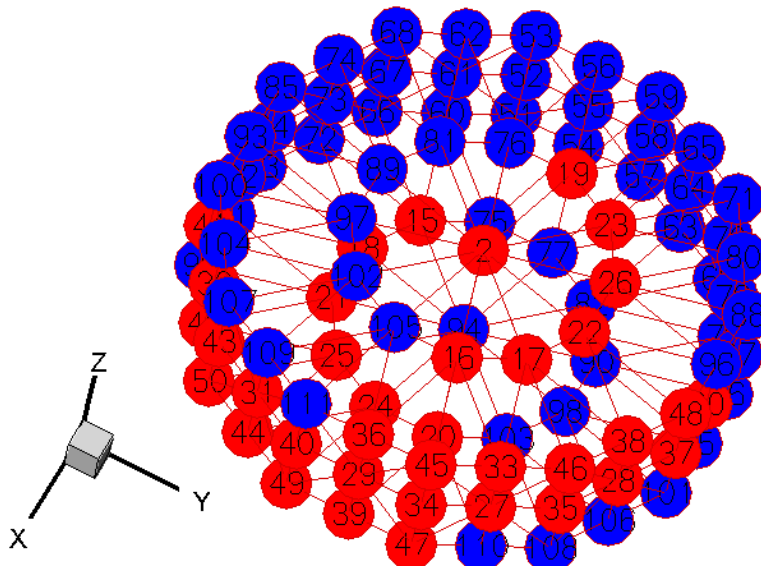
Figure 1. Orientation distribution function (ODF) representation for the hexagonal close-packed (HCP) Ti-7Al microstructure (the independent ODFs are shown in red).